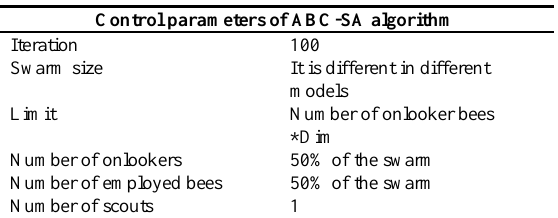
Table 1. Control parameters of the ABC-SA algorithm.